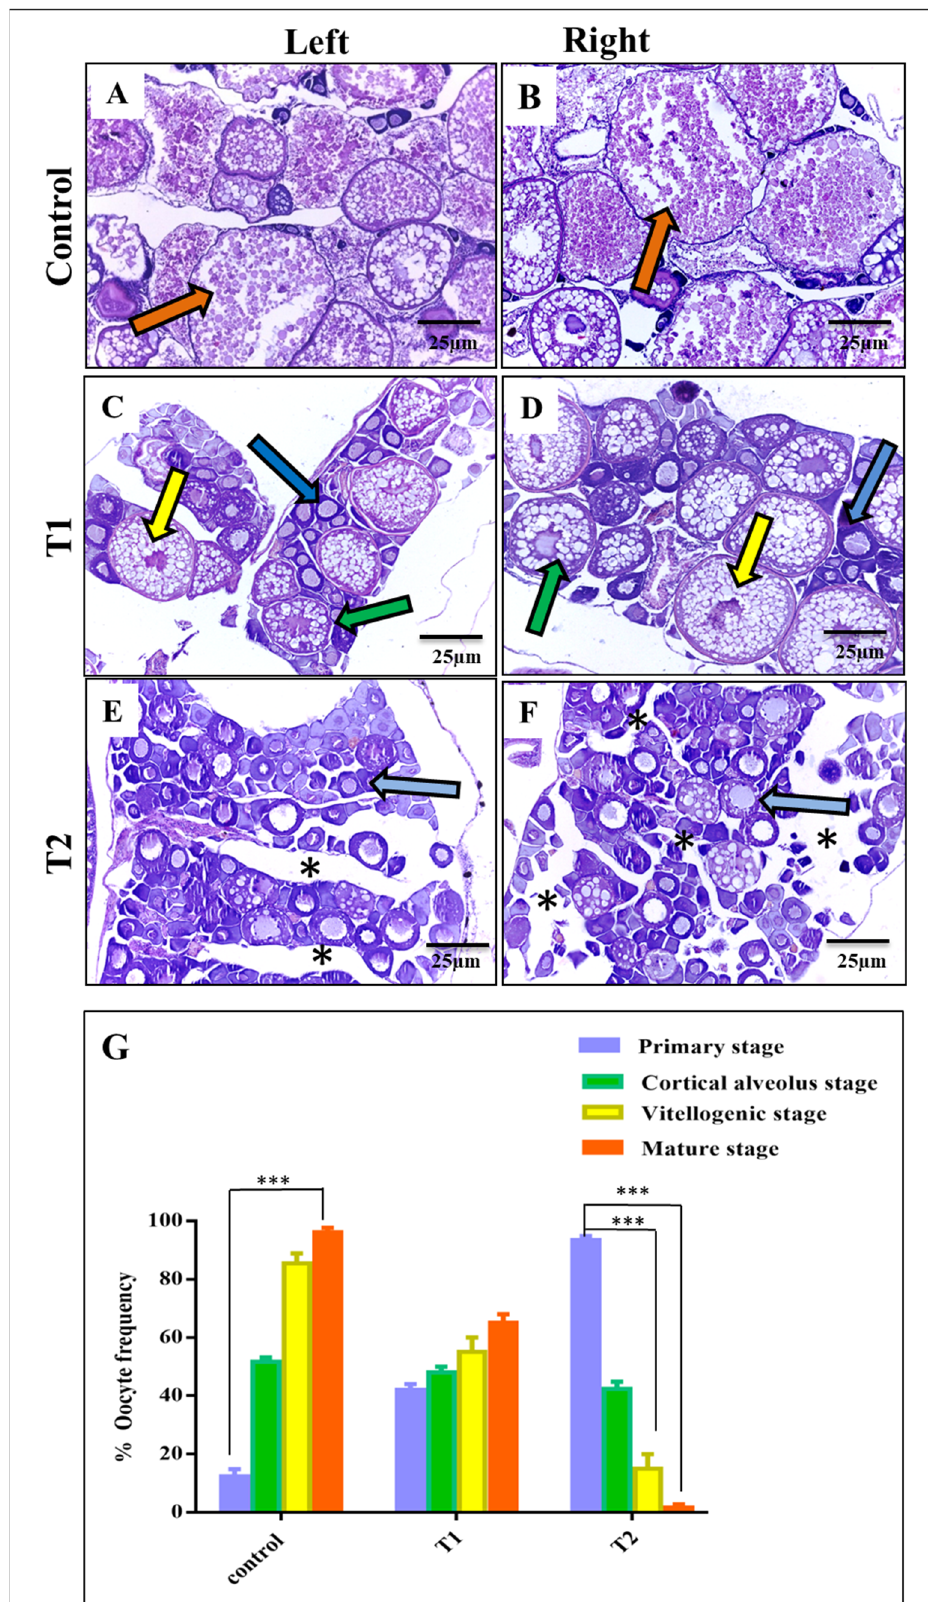
Figure 4. Comparative histological observations of the control, T1, and T2 left and right ovaries (H&E, 25 µ m) : ( A , B ) Photomicrographs showing the left and right ovaries of the control; notice